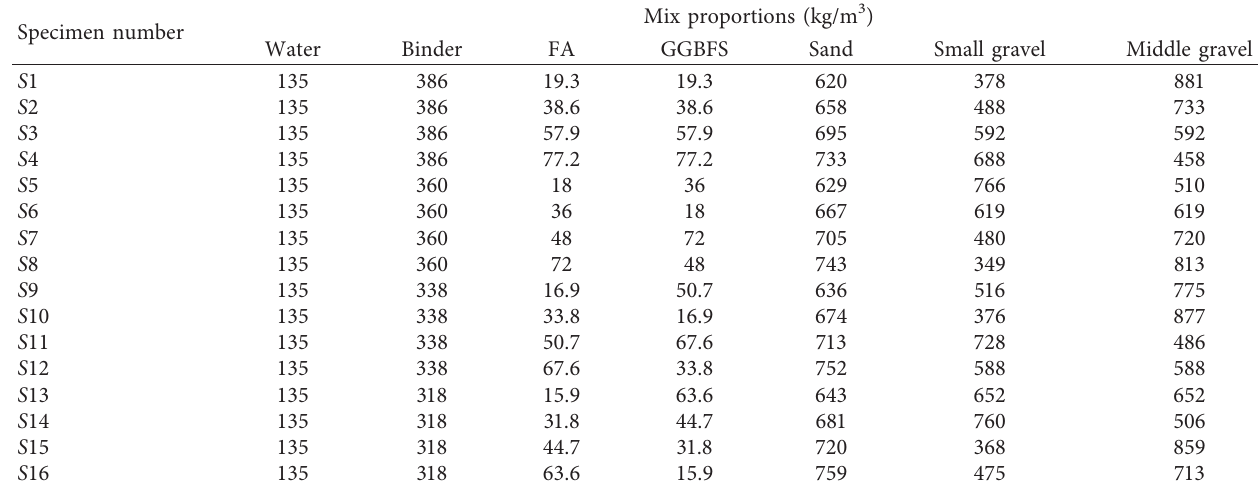
Table 3: Mix proportions.